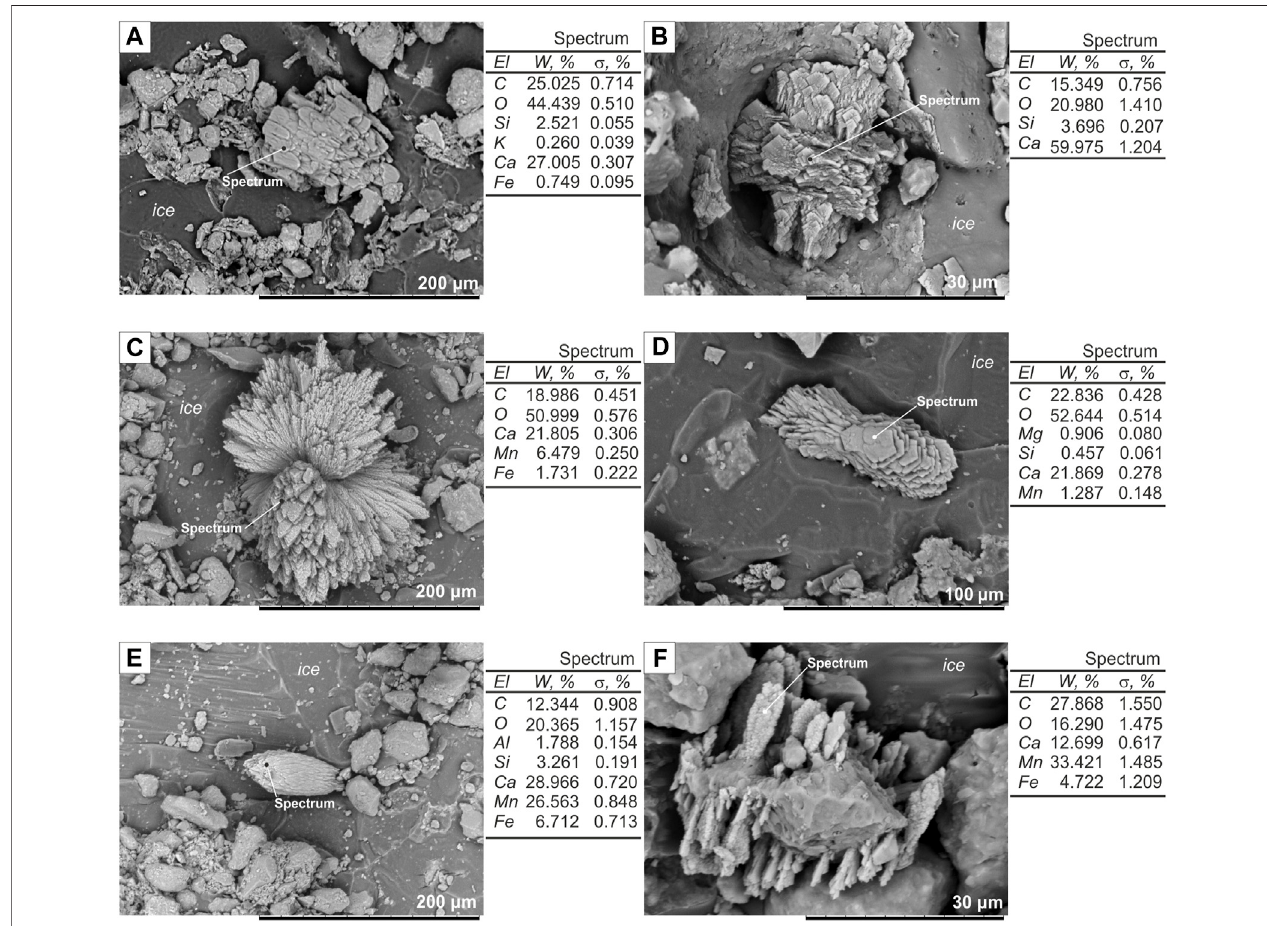
FIGURE 3 | Morphology of the authigenic carbonates under SEM-EDX. El (cid:2) element; W% (cid:2) weight percent; σ % (cid:2) error. (A) Parallel intergrowth of calcite crystals, Kur ’ ishka site, sampled at 17 m arl; (B) polysynthetic twinning of rhombohedral calcite crystals, Duvanny Yar site, sampled at 36 m arl; (C) rosette-like aragonite aggregate, Kur ’ ishka site, sampled at 19 m arl; (D) twinning of acicular and prismatic aragonite crystals, Kolymskoe sampled at 25 m arl; (E) columnar manganocalcite intergrowth, Kur ’ ishka site, sampled at 21 m arl; (F) Ca-rhodochrosite druse, Kur ’ ishka site, sampled at 29 m arl